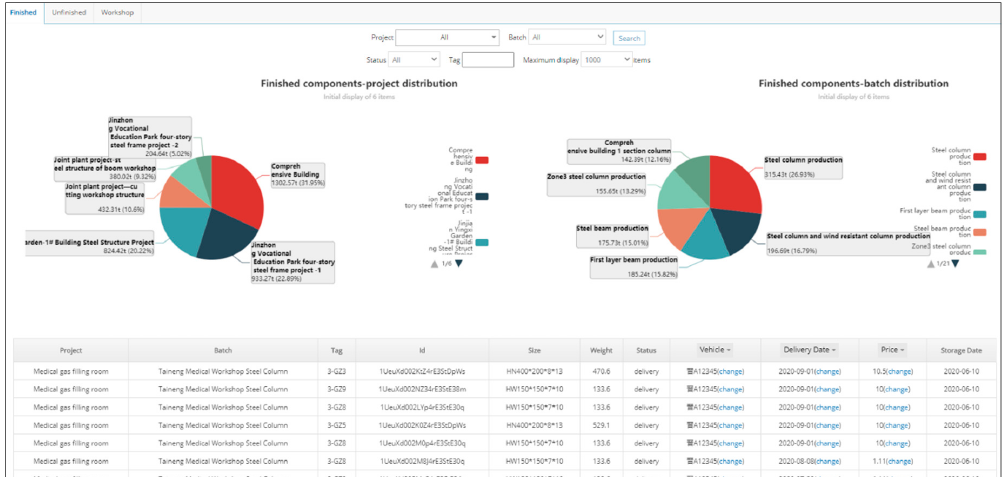
Figure 12. The quantity of components that are involved in the manufacturing of each project. Appl. Sci. 2020 , 10 , x FOR PEER REVIEW